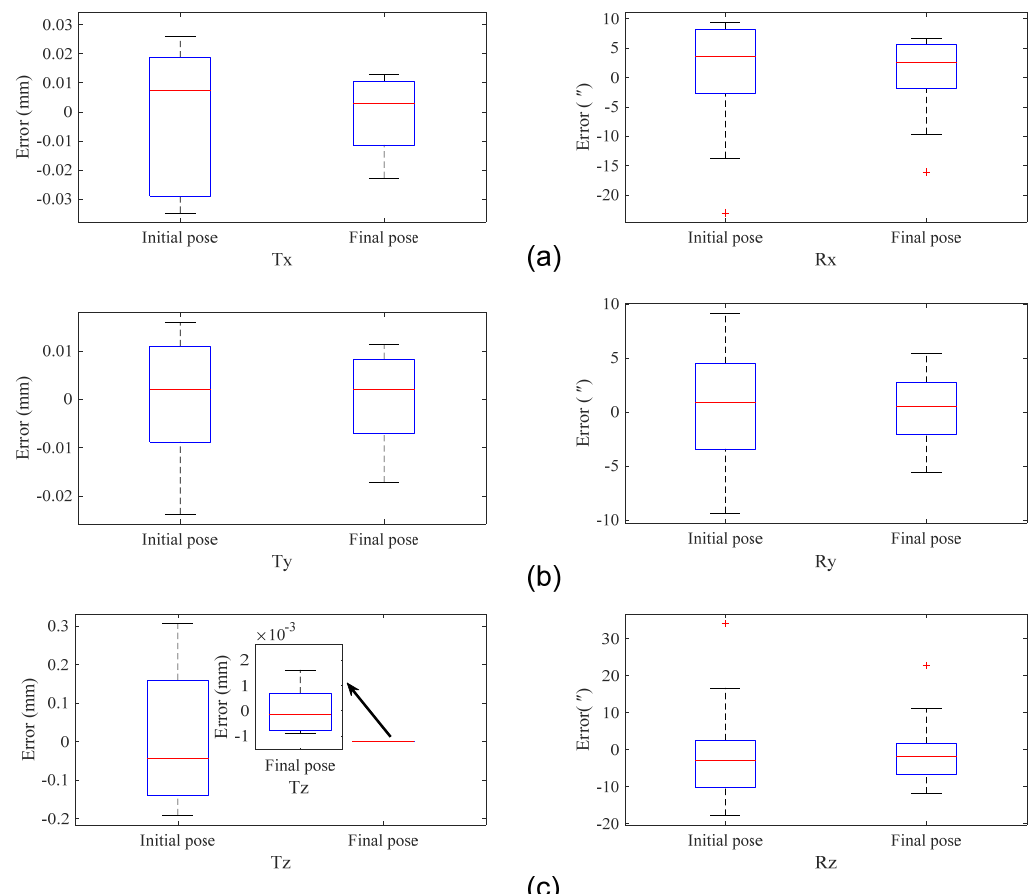
Figure 8. Measurement error comparison of the initial pose and the final pose. Measurement results and errors in ( a ) the x − axis direction; ( b ) the y − axis direction; ( c ) the z − axis direction.